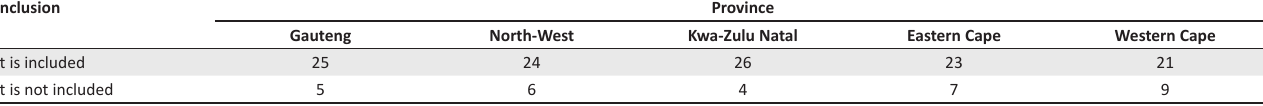
TABLE 3: Questionnaire responses by educators on whether hazard and disaster learning outcomes are included in classroom teaching.